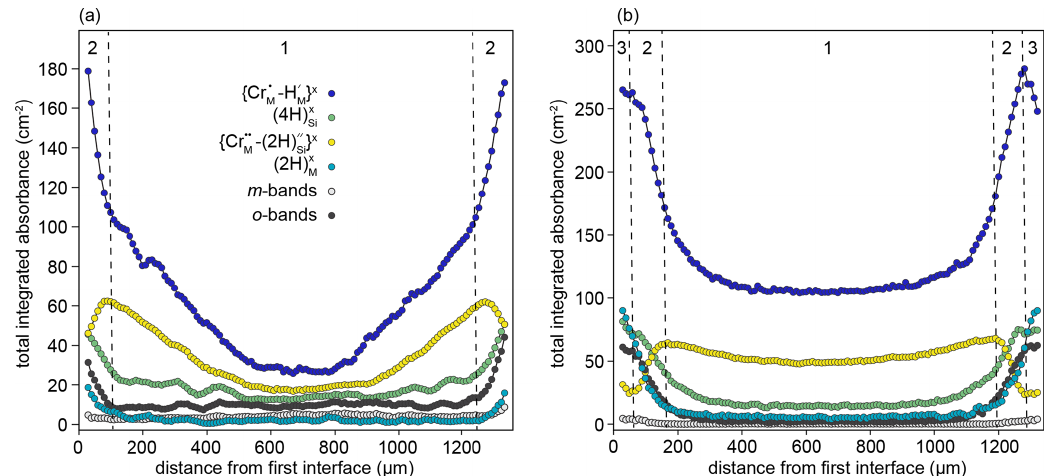
Figure 8. Rim-to-rim profiles of FTIR bands assigned to different defects for samples prepared at (a) 1200 ◦ C and (b) 1300 ◦ C. Zones 1, 2, and 3 are defined by the dashed lines and represent core, transitional, and interface regions. Note that the zone “1”–“2” boundaries are further into the crystal than designated by the XANES data: this is due to the higher experimental temperature.